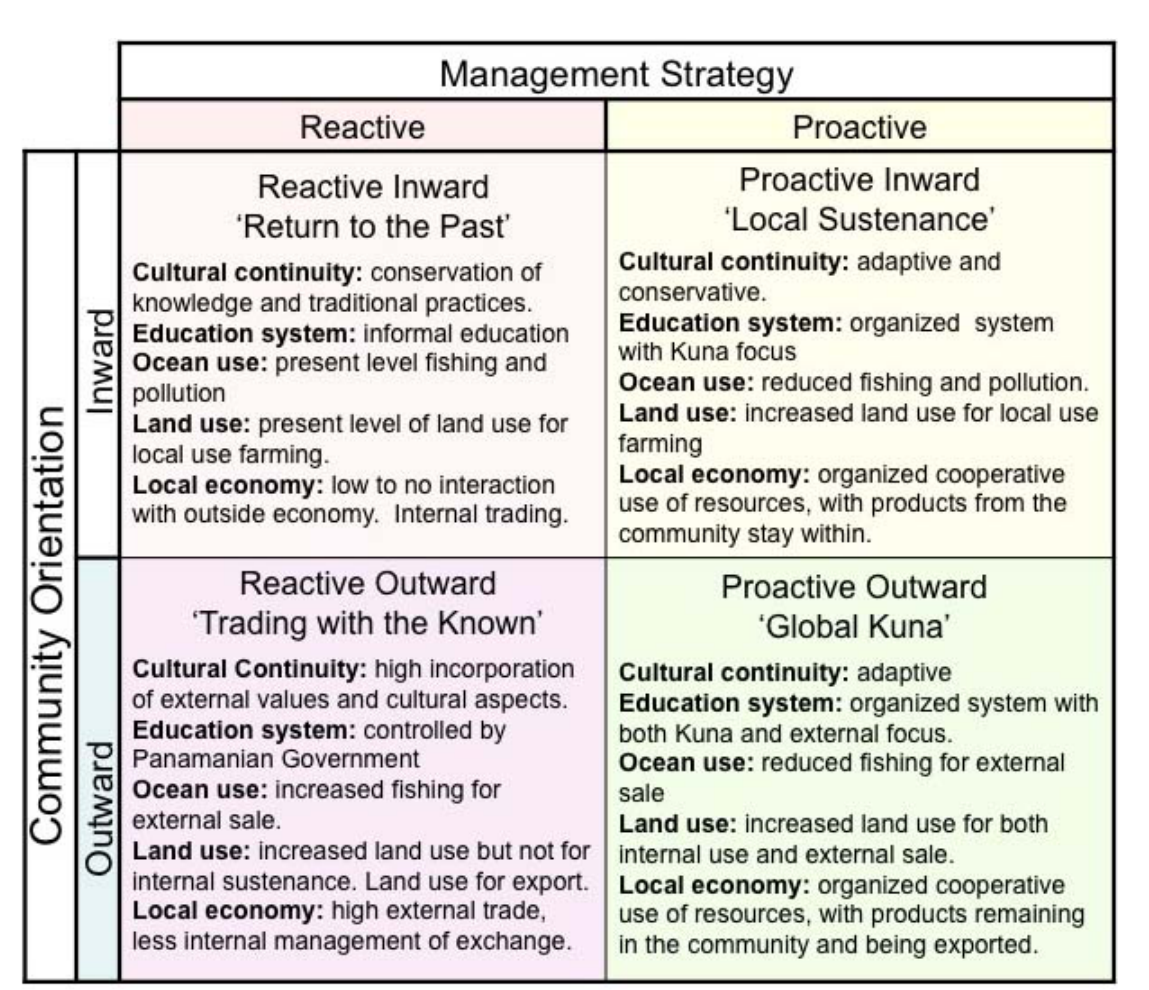
Fig. 2. The Vision Scenario Matrix structure with